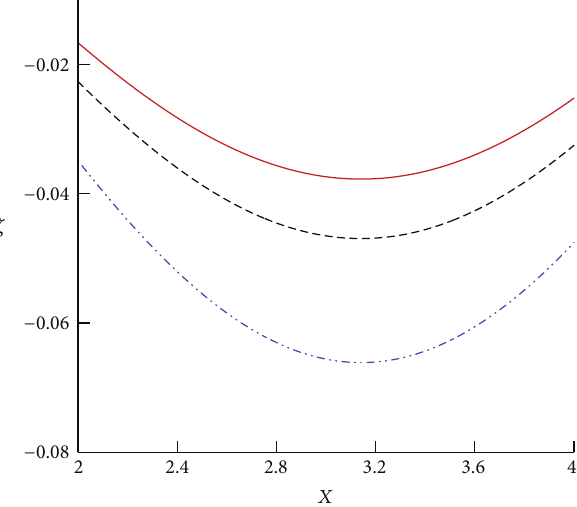
Figure 8: Variation of the plate deflection 𝜁(𝑋) near the trough versus 𝑋 for different plate thicknesses 𝑑 . Solid line: 𝑑 = 0.001 ; dashed line: 𝑑 = 0.005 ; dash-dot-dotted line: 𝑑 = 0.01